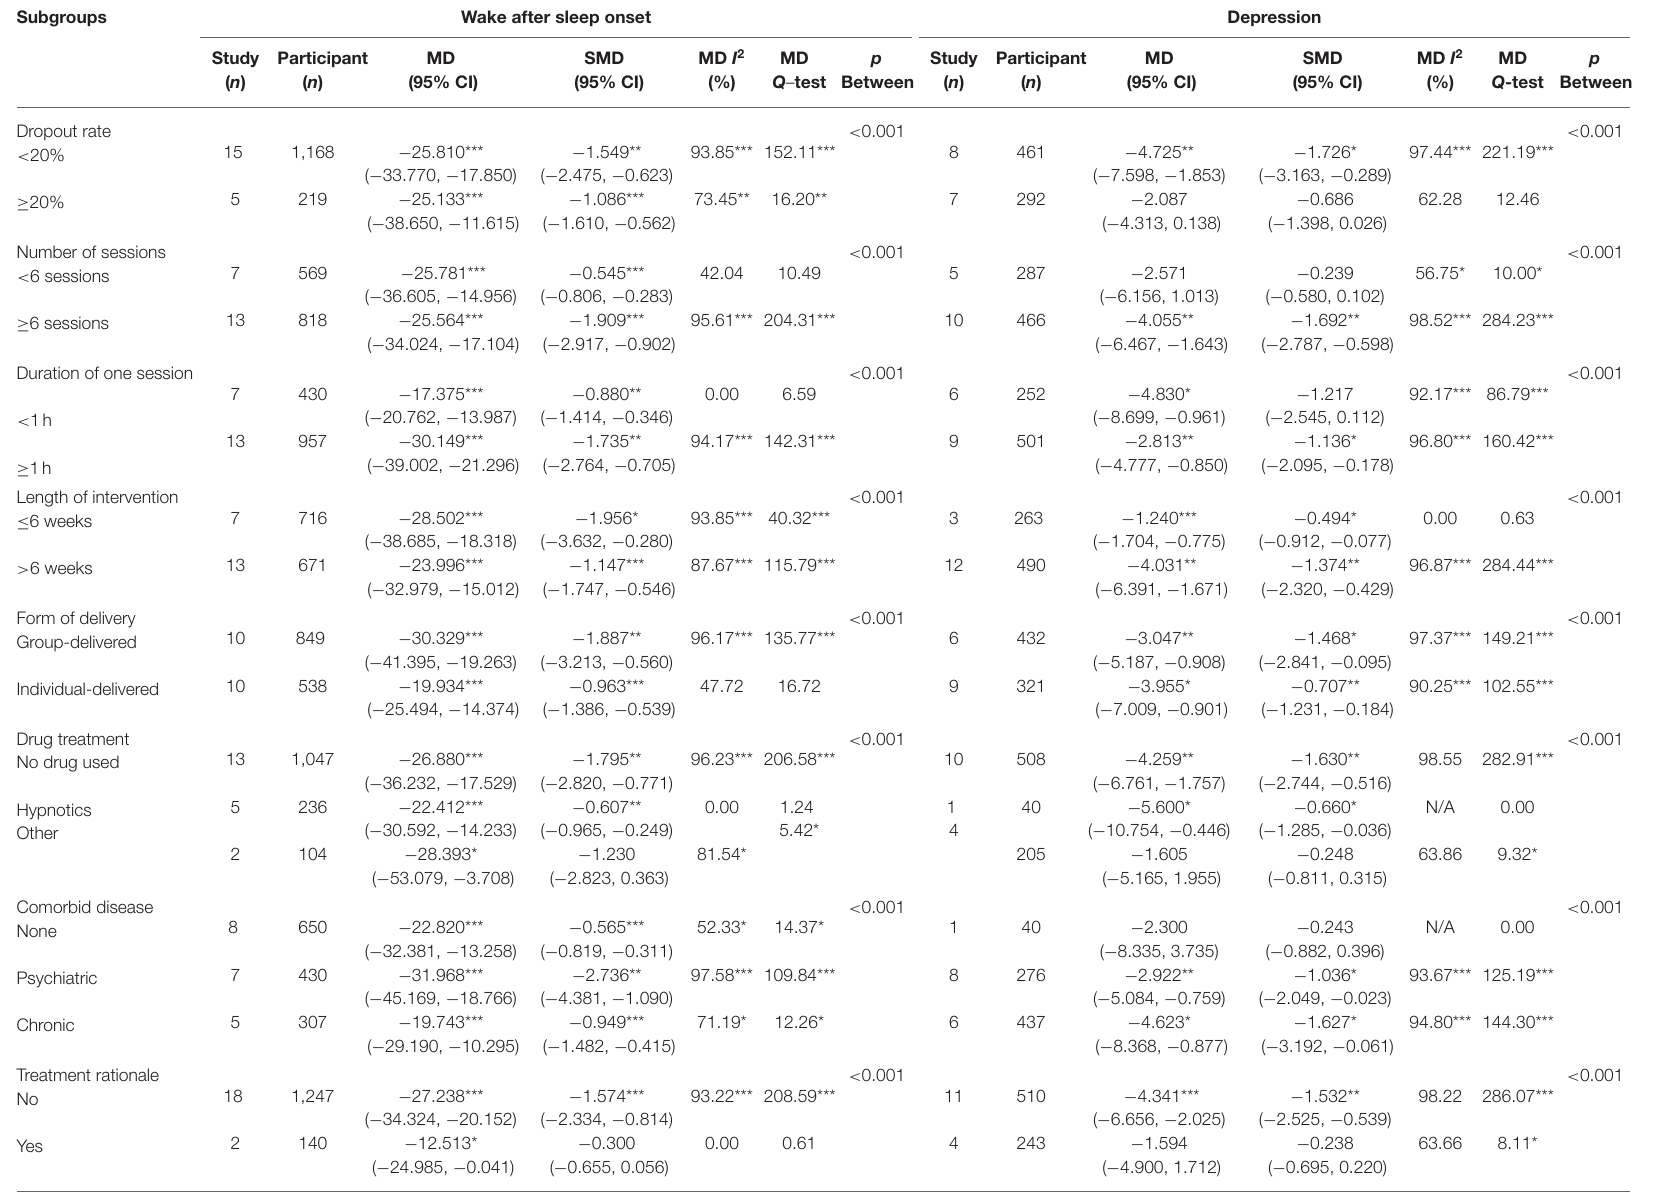
TABLE 5 | Subgroup analysis for wake after sleep onset and